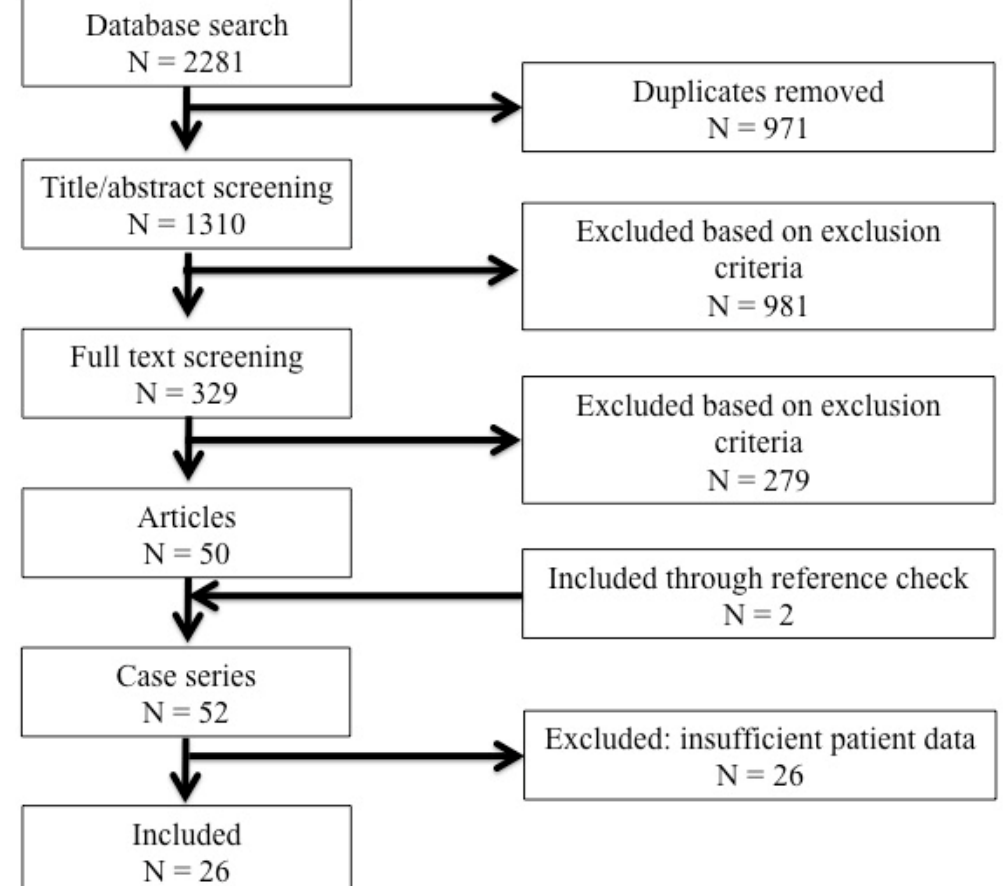
Figure 1. PRISMA-guided systematic search.